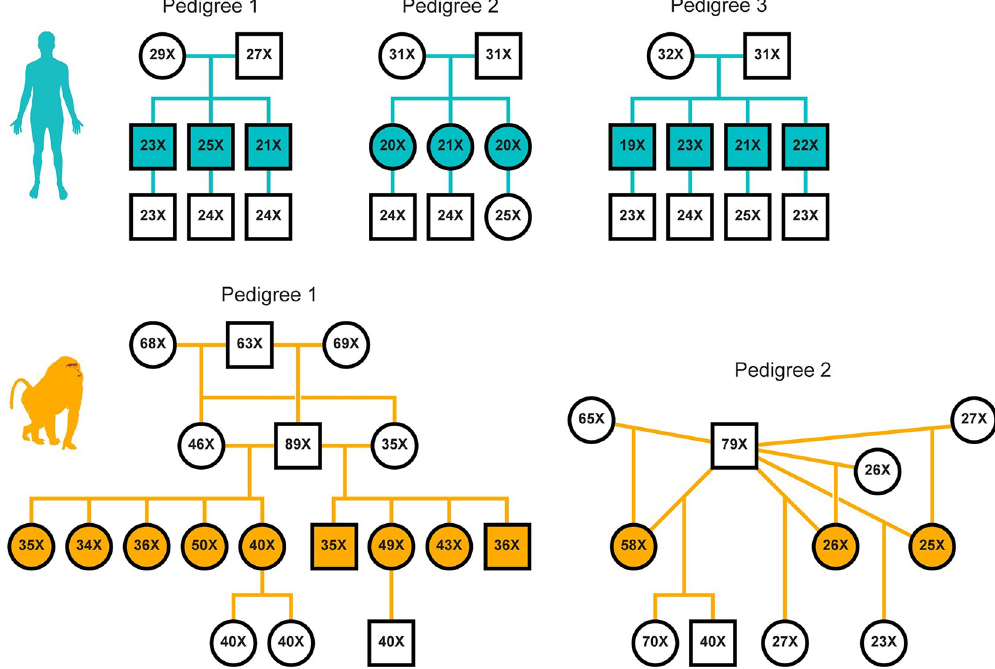
Fig 1. Pedigrees and mean depth of coverage of the sequenced individuals. Relationships among individuals in 3 human families (top row, teal) and 2 extended baboon pedigrees (bottom row, orange) are shown. Squares and circles represent males and females, respectively, and are annotated for the mean depth of sequencing coverage of the individual. Filled shapes indicate the focal F 1 individuals in which mutations were called. Sample identifiers and birth dates for all individuals are specified in S2 Table and S3